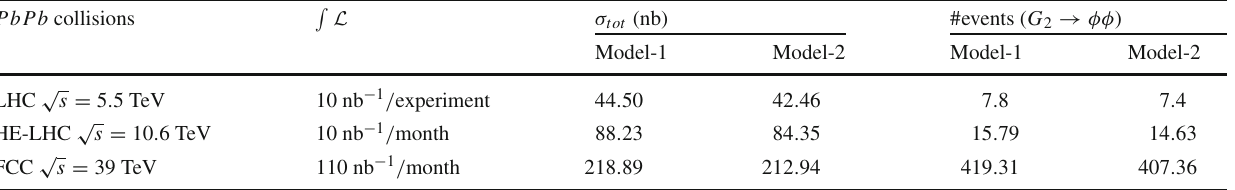
[40,41]. The table includes the results of both model-1 and model-2 calculations. Here we set the previously mentioned coupling (cid:13) L come from